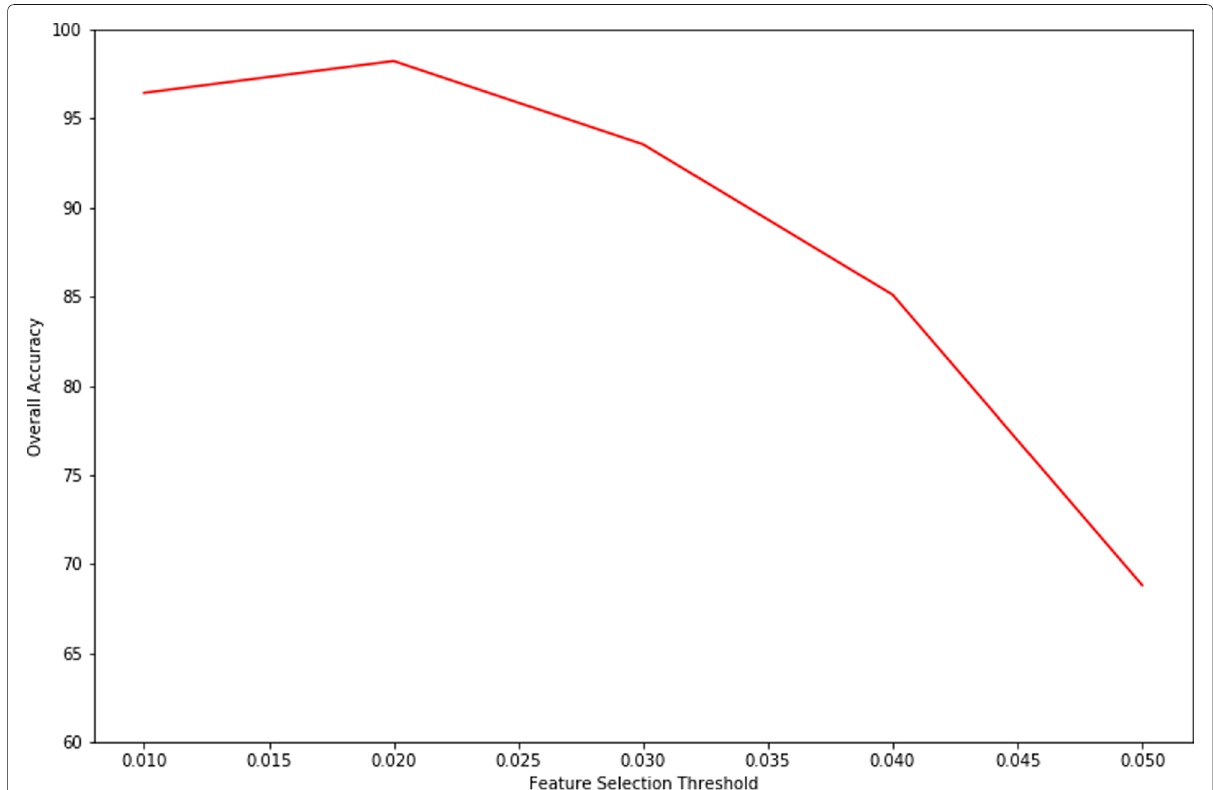
Fig. 5 Performance based on feature score threshold selection